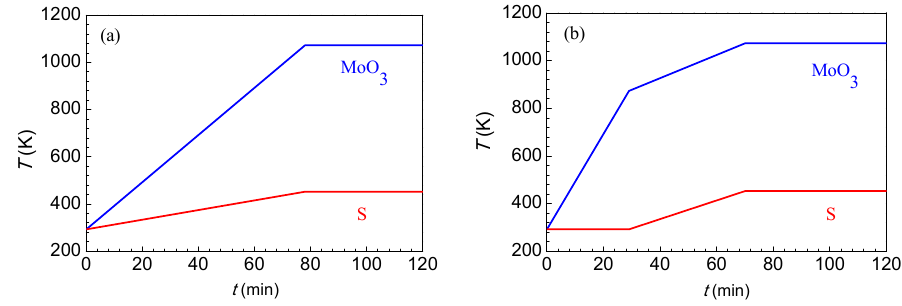
Figure 2. Heating methods to prepare MoS 2 : ( a ) one-step heating and ( b ) two-step heating.